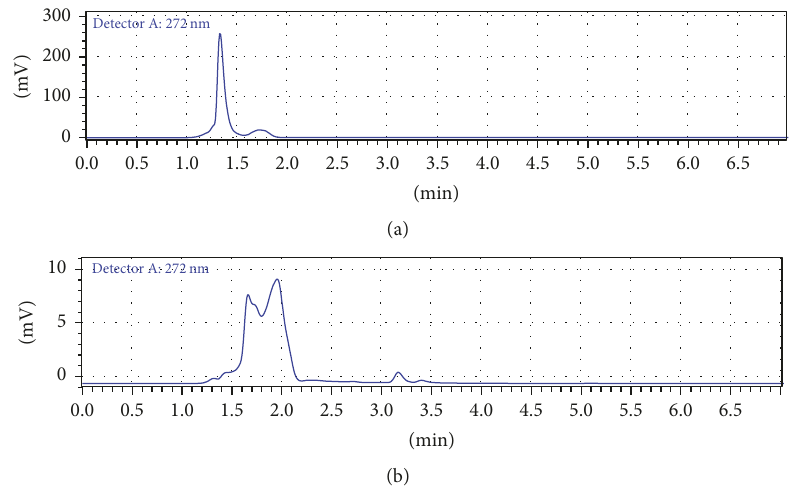
Figure 4: Chromatograms showing the complete degradation of pro-NP in (a) 0.1 N NaOH and (b) 0.01 N NaOH.